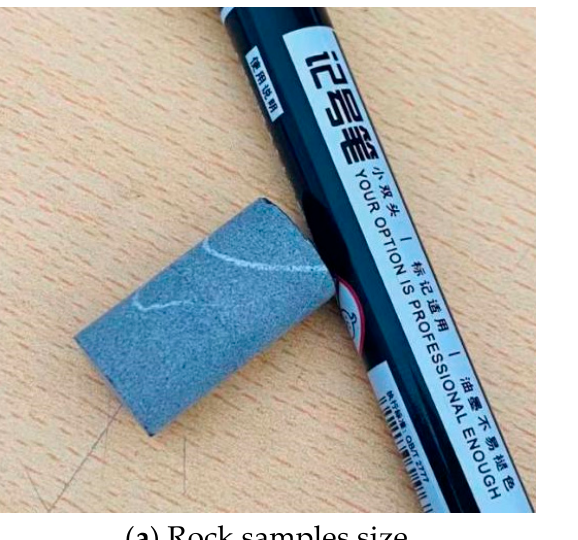
Figure 4. A supplementary figure of the X-ray diffraction whole-rock mineral analysis. Drill a cylindrical rock sample with a core drill with a diameter of 12 mm and a height Table 2. Main chemical composition content of the rock sample and LS (wt%). of 24 mm (Figure 5), wash the rock sample with deionized water, and dry it in a drying box at 105 ◦ C for 12 h. Weigh the test piece W1 before dissolution with an electronic balance with a range of approximately 0–120 g and an accuracy of 0.01 mg.